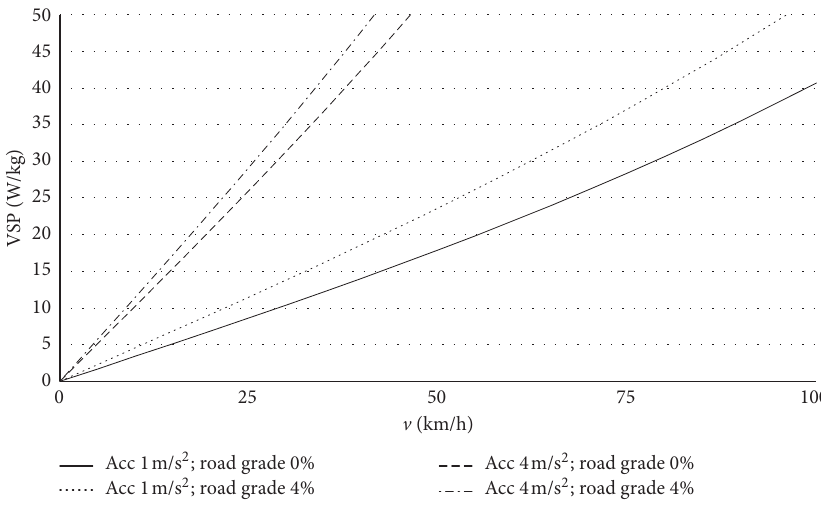
Figure 4: VSP for different slopes, speeds, and